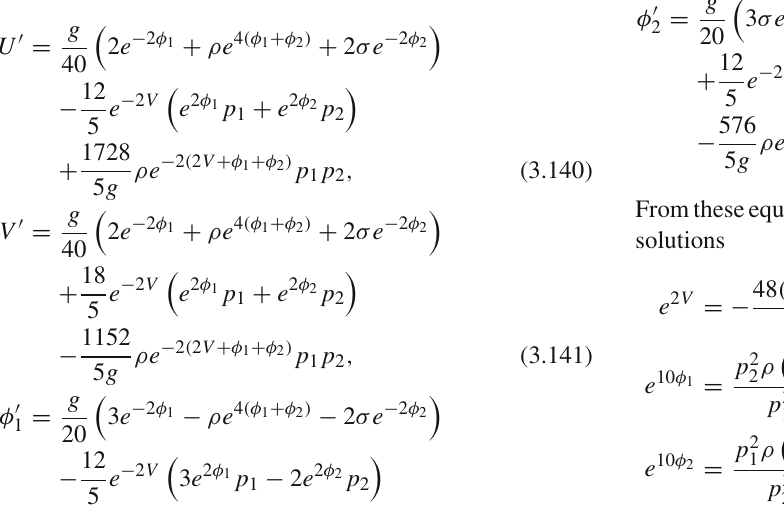
With the γ r projector (3.21) and the scalar coset represen- tative (3.13), the corresponding BPS equations